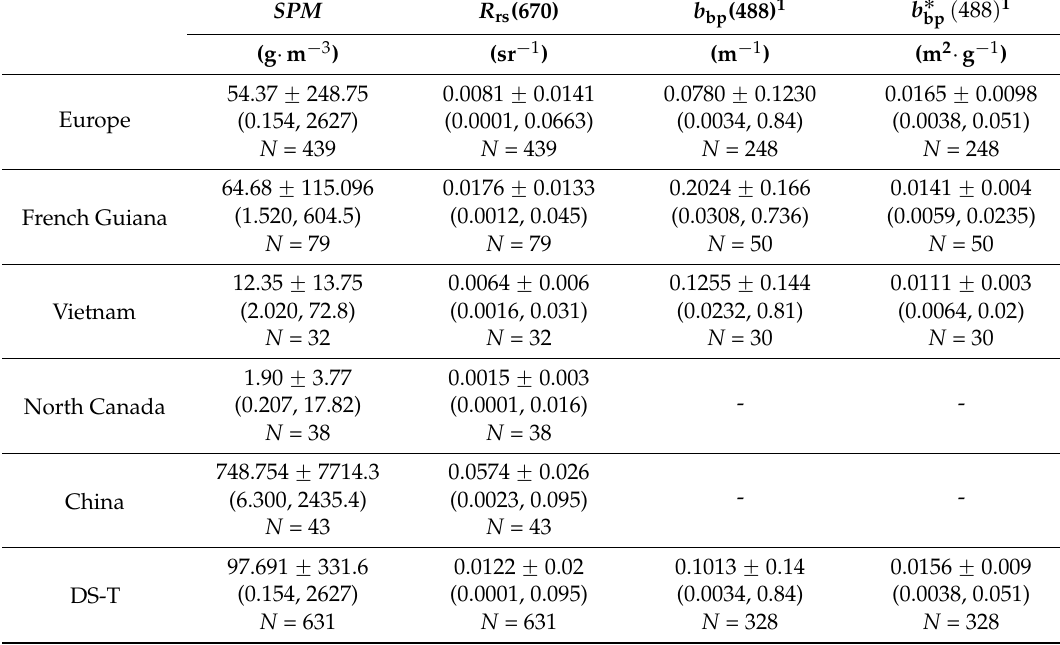
Table 2. Mean, standard deviation, minimum, and maximum values of SPM , R rs (670), b bp (488)and p 488 q for each specific regions. N represents the number of measurements in each sub-region. b ˚ bp SPM R rs (670) b bp (488) 1 b ˚ bp p 488 q